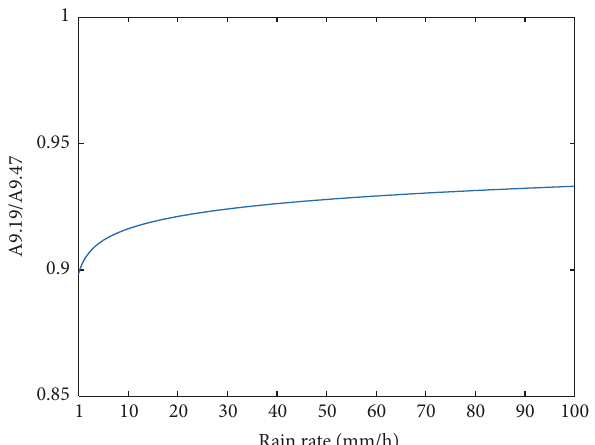
Figure 6: Relationship between specific attenuation due to rain at 9.19 GHz and 9.47 GHz.